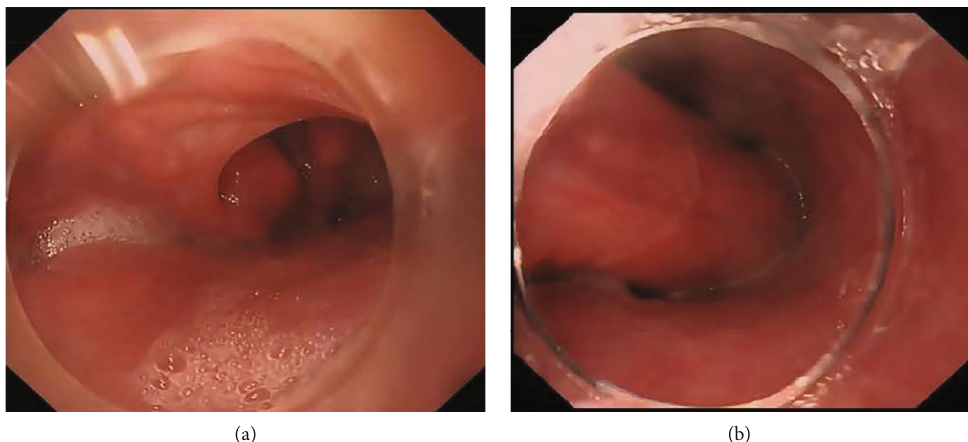
Figure 1: A large protruded tumor (30 cm) was seen in the esophageal lumen; its pedicle originated from the hypopharynx and prolapsed into the